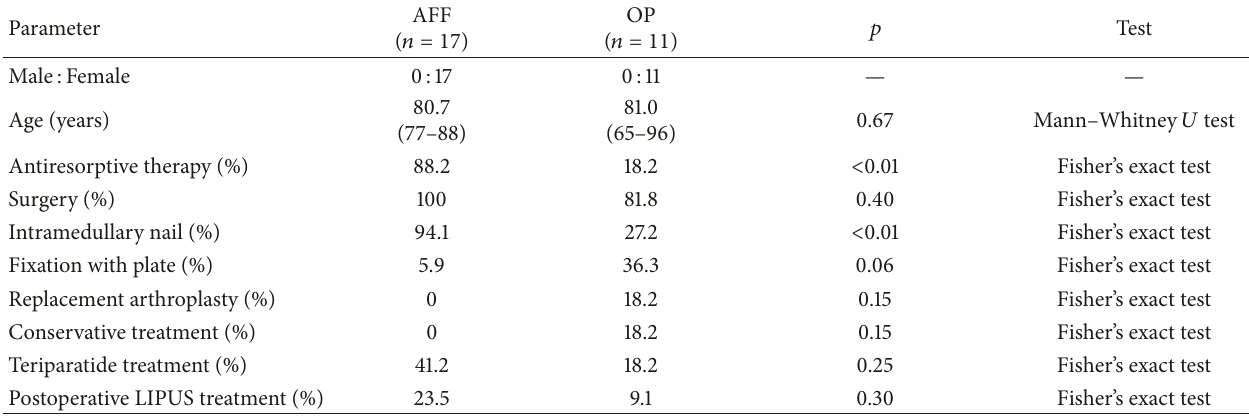
Table 1: Patient characteristics and